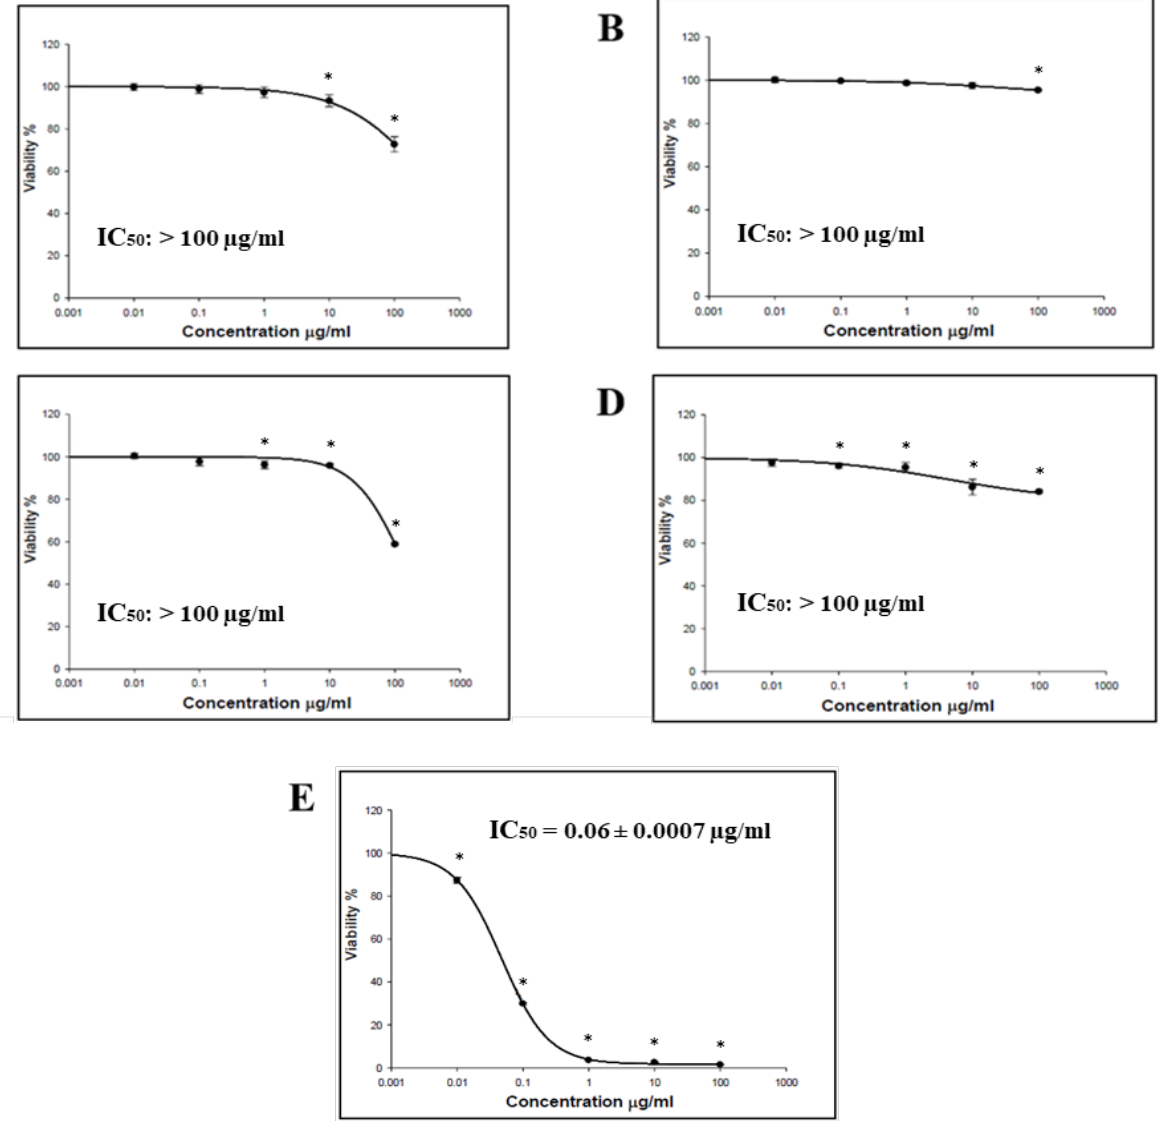
Figure 1. Representative dose–response plots demonstrating the effect of different O. baccatus methanolic extracts on HCT-116 cancer cell growth: ( A ) whole plant’s extract ( B ) flowers’ extract; ( C ) branches’ extract; ( D ) roots’ extract; and ( E ) doxorubicin. The experiment was repeated three times. Dots and error bars represent mean ± S.D. * p < 0.05 vs. control .